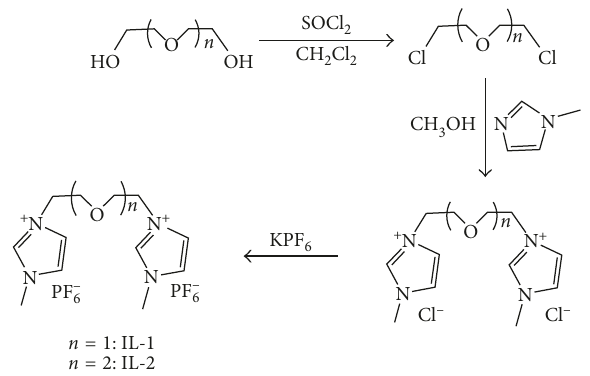
Figure 1: Synthesis route of two thermoregulated dicationic ionic